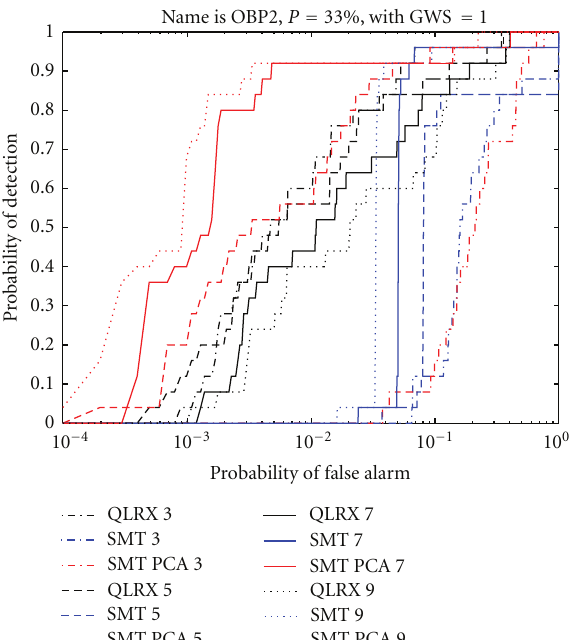
Figure 8: Similar to Figure 7 for the HAR dataset.